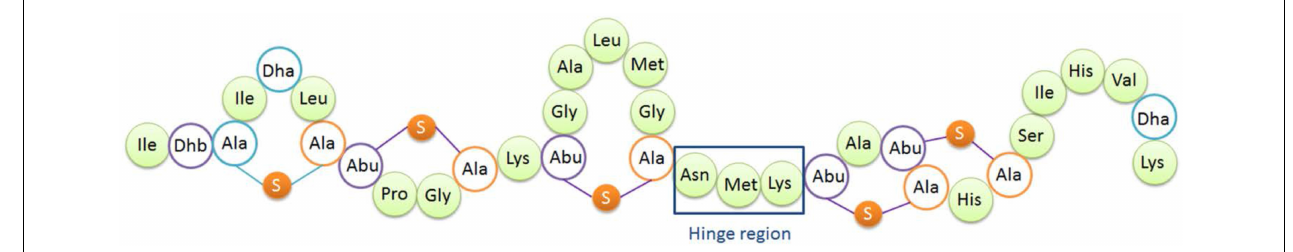
FIGURE 1 | Structure of nisin A. Dha, dehydroalanine; Dhb, dehydrobutyrine; Ala-S-Ala, lanthionine; Abu-S-Ala, β -methyllanthionine. The hinge region (Asn-Met-Lys) is indicated.